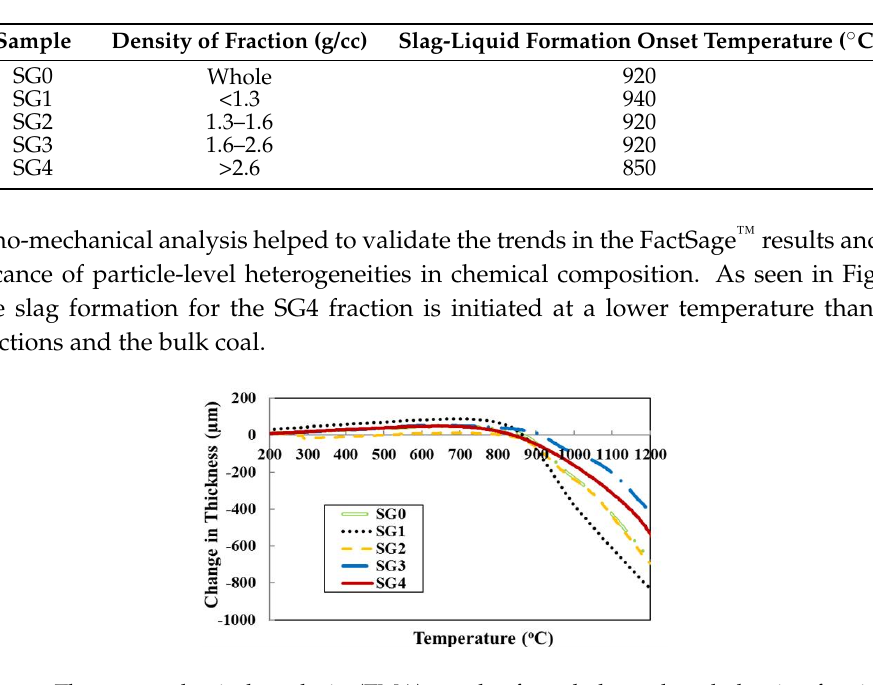
Figure 3. Thermo ‐ mechanical analysis (TMA) results for whole coal and density fractions of Figure Pittsburgh No. 8 seam coal.